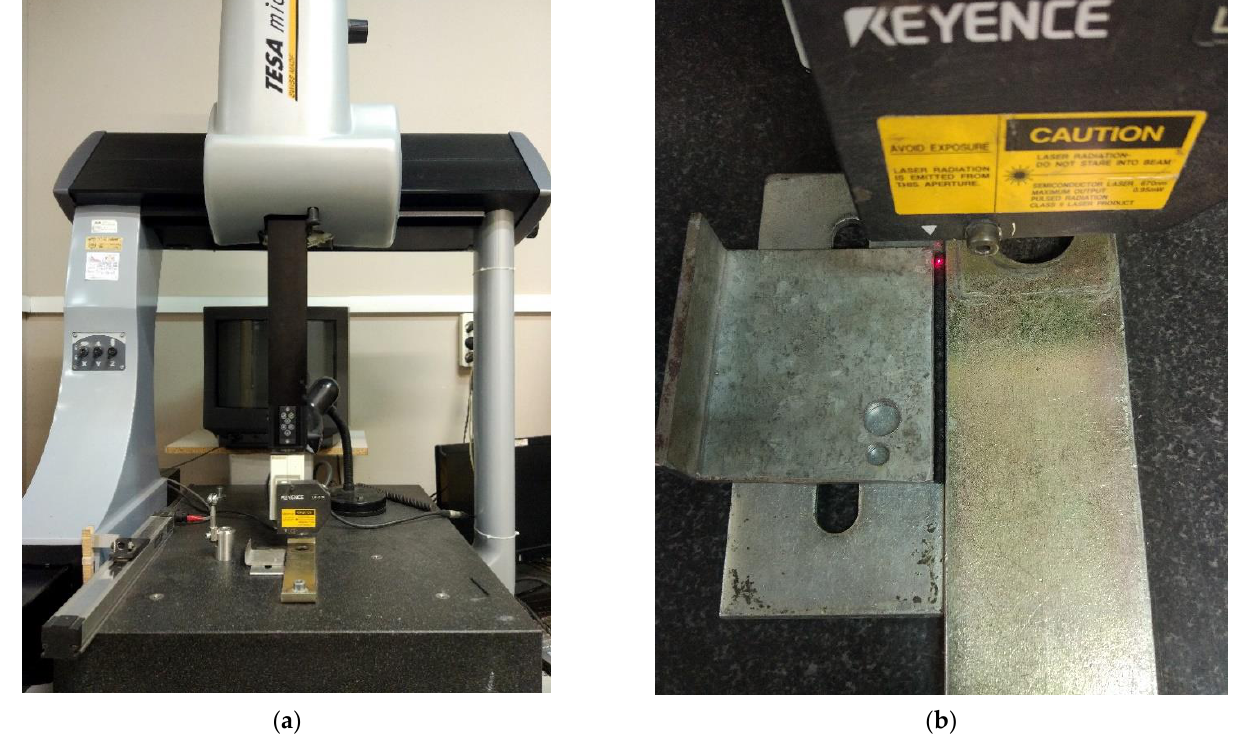
Figure 4. ( a ) Three-dimensional table. ( b ) Detailed fibre measurement.